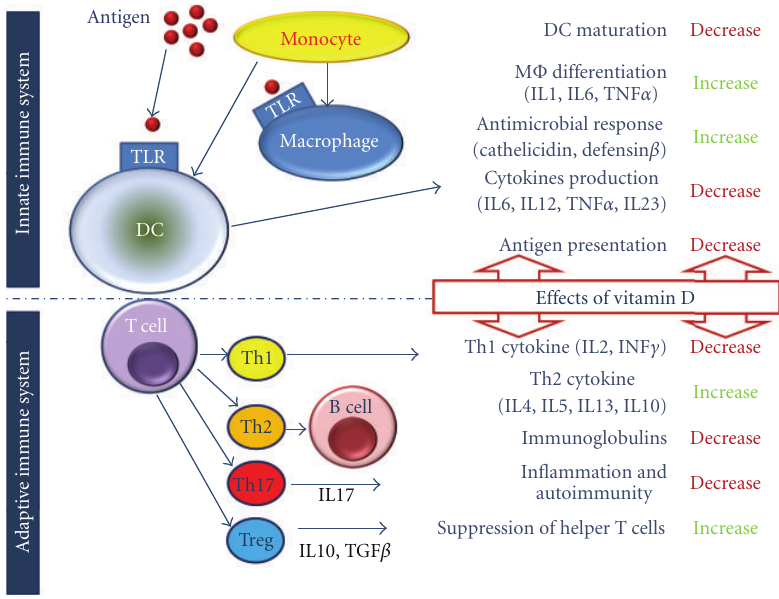
Figure 1: Schematic representation of the immune e ff ects of vitamin D: this figure depicts the principal innate and adaptive immune responses to an antigenic challenge and the influence of vitamin D (positive regulation: increase or negative regulation: decrease) on these responses (B cell: B lymphocyte, cyto T cell, cytotoxic T cell, DC: dendritic cell, M Φ : macrophage T cell: T lymphocyte; TLR: toll-like receptor; TH: helper T cell; Treg: regulatory T cell; IL: interleukin; TNF: tumor necrosis factor; and INF: interferon).